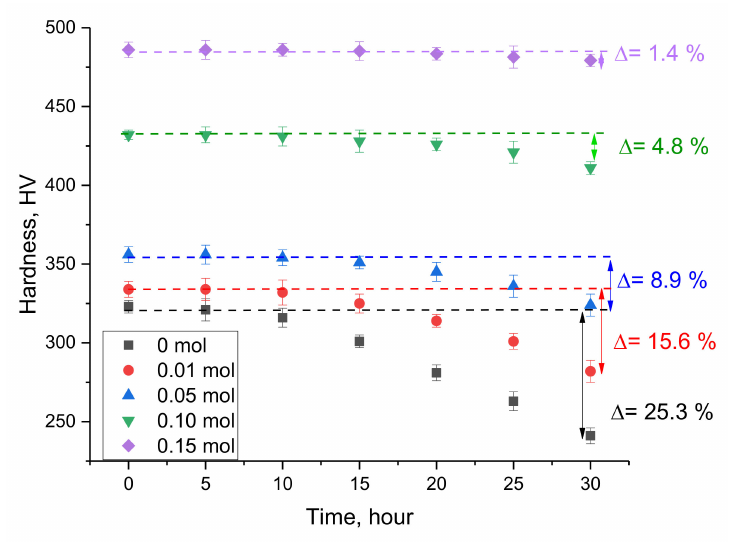
Figure 6. Results of changes in the hardness value during the simulation of aging